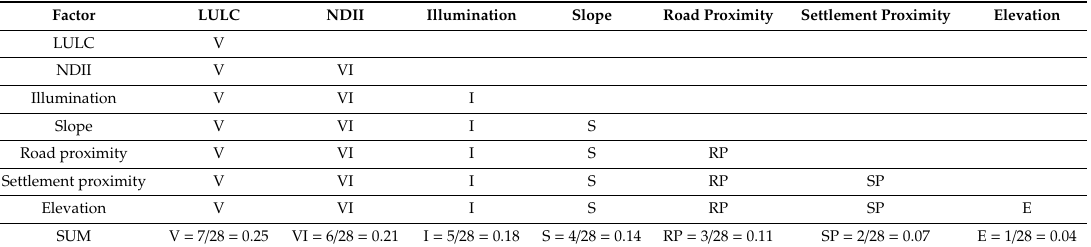
Table 4. Pair-wise comparison of the fire risk factors for the extraction of the relevant